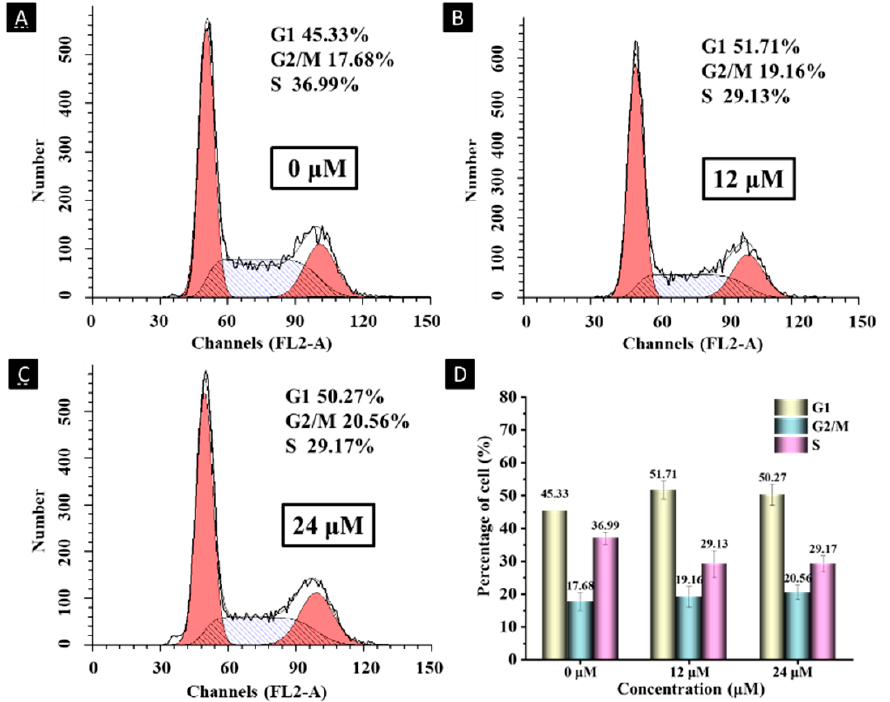
Figure 6. Compound I 23 affected the cell cycle distribution in HepG2 cancer cells. Untreated (Control) and cells treated with compound I 23 at 24 μ M concentration for 24 h.